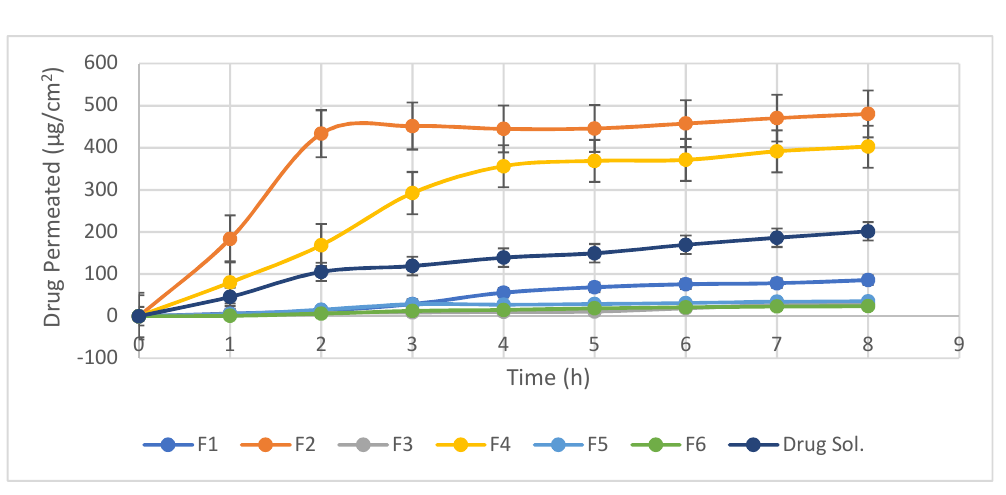
Figure 2. Ex-vivo corneal permeation profile of different formulae. Table 3. Transcorneal permeation parameters of different formulae, n = 3.